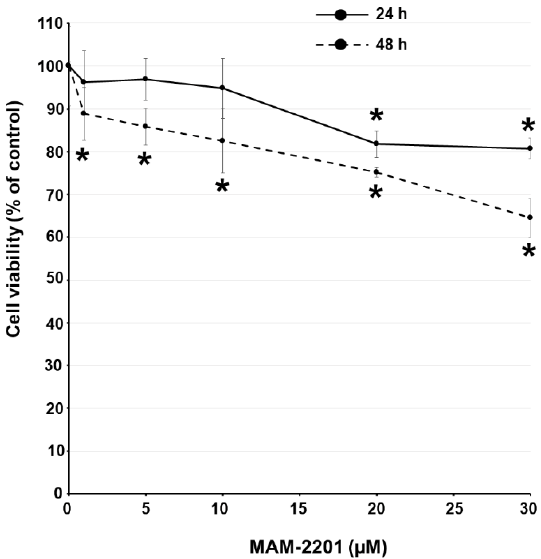
Figure 5. Cell viability evaluation by trypan blue (TB) exclusion test; cytotoxicity effects after 24 and 48 h of exposure to increasing concentrations of MAM-2201 (1–30 µ M). Data are normalized to the mean value obtained under control conditions, expressed as percentages (% of control), and plotted as the means ± S.E. * p < 0.05, statistical analysis by one-way ANOVA followed by Tukey’s multiple comparisons test.